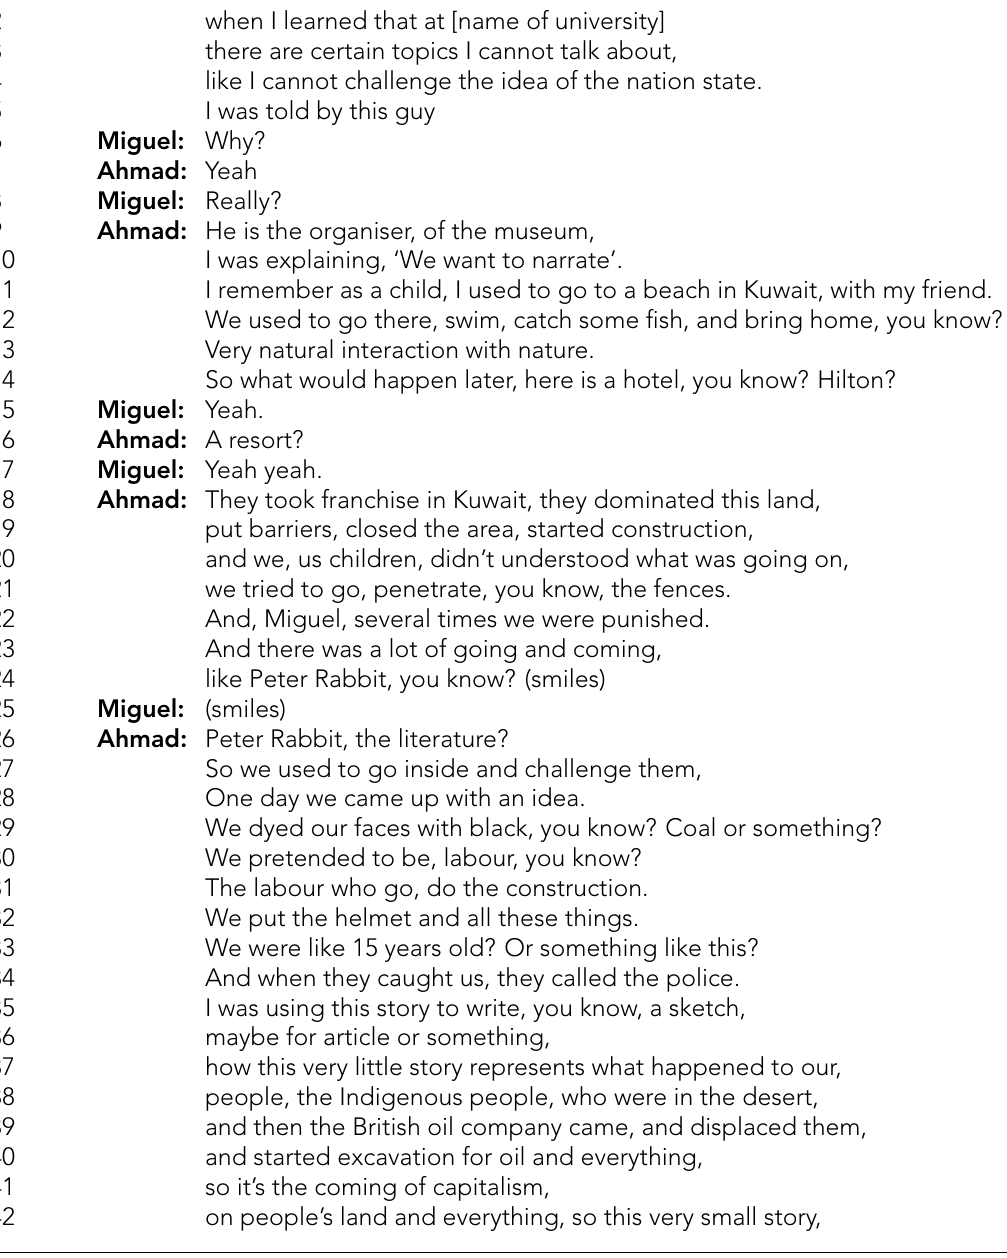
Figure 2. ‘The straw that broke the camel’s back’